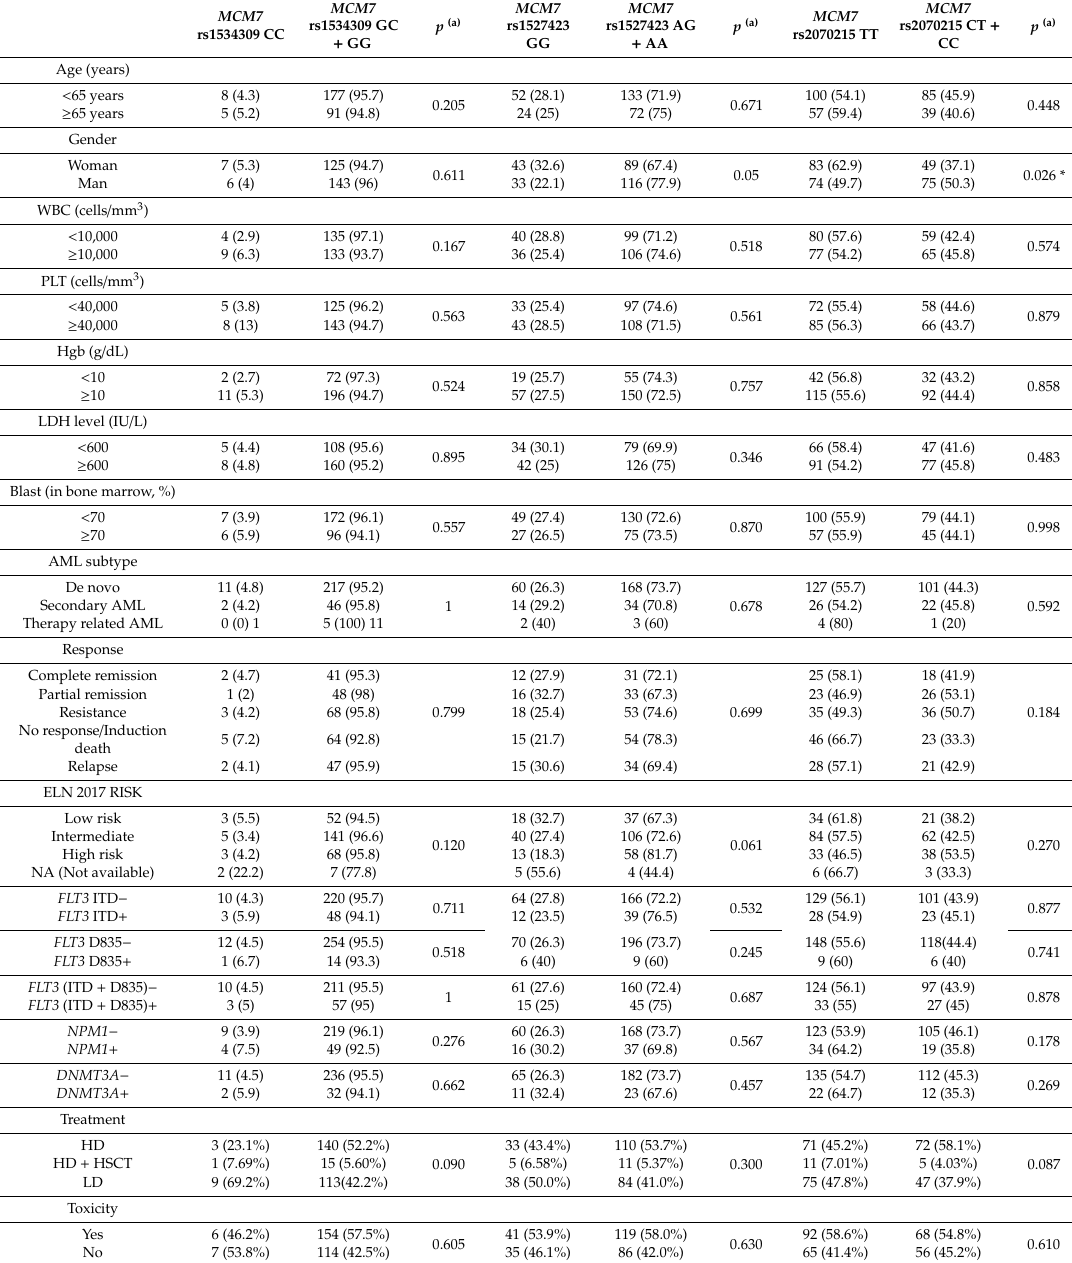
Table 3. Demographic and clinical patients’ features according to the genotypes for rs1534309, rs1527423, and